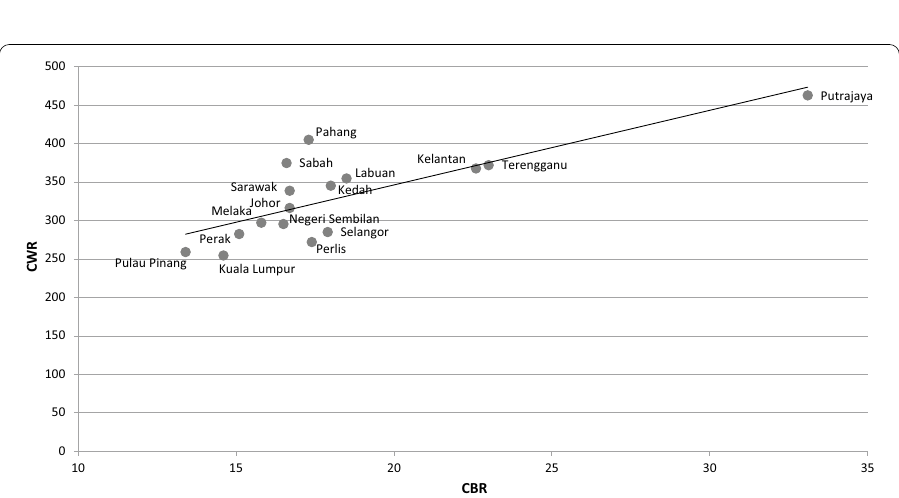
Fig. 8 CBR and CWR by state, Malaysia, 2010. Spearman correlation coefficient Vital statistics, Malaysia, 2020; Population and housing census of Malaysia: Population distribution and basic demographic characteristics, 2010 (DOSM, 2011a,